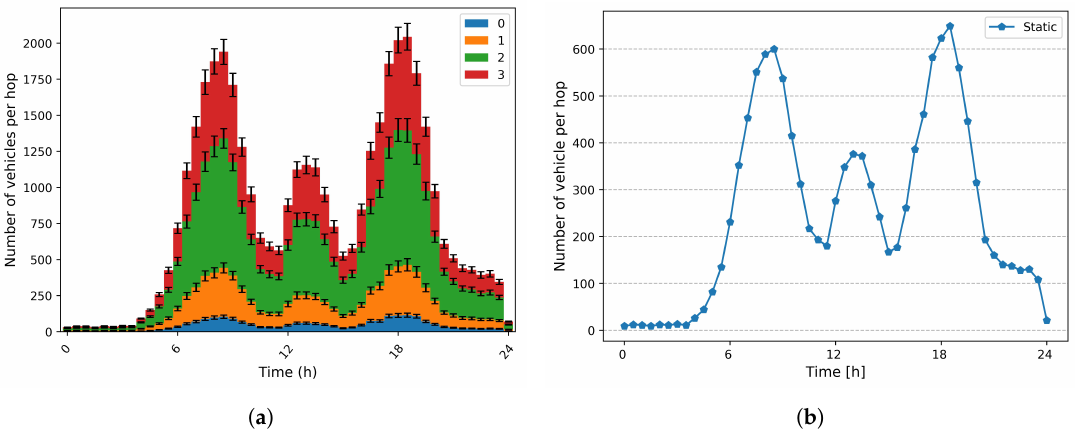
Figure 8. Placement performance. ( a ) Number of vehicles per hop; ( b ) Number of vehicle per 3